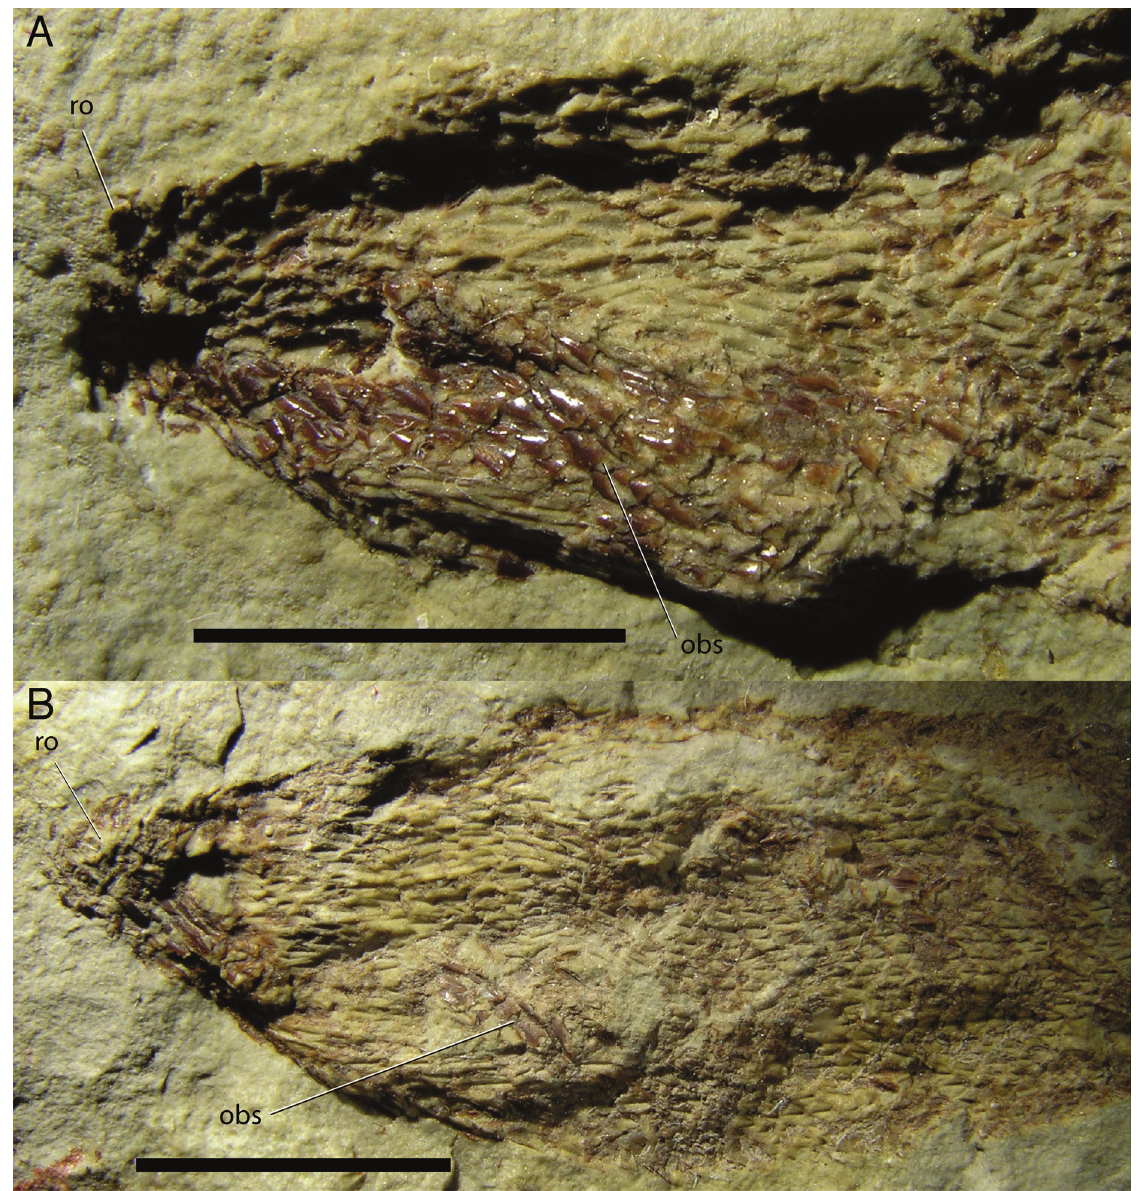
Fig. 5. Phlebolepis elegans Pander. Cephalobranchial region of specimens in lateral view, from Himmiste-Kuigu, Saaremaa, Estonia, imaged wet. A , TUG 865-27-2; B , TUG 865-16-2. Scale bars are each 1 cm. Abbreviations: obs, oblique branchial scales; ro,